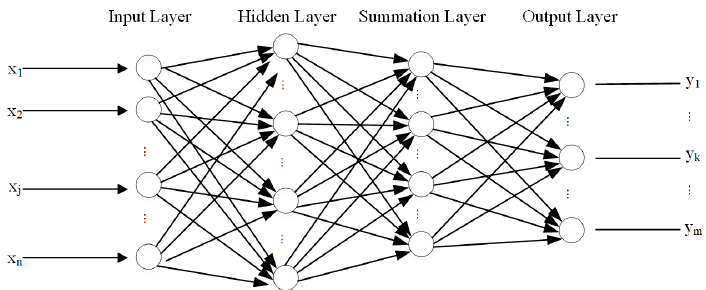
Figure 3. GRNN block diagram. X = [x 1 , x 2 , ... , x n ] is the input vector, Y = [y 1 , y k , ... , y m ] is the output vector.